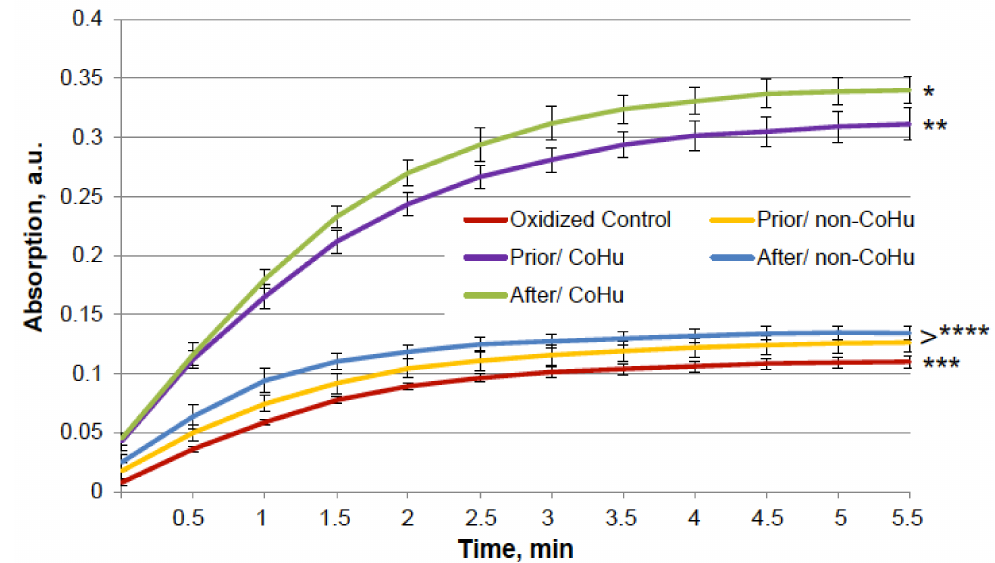
Figure 6. Effect of CoHu on oxidized alkaline phosphatase activity. Data presented as mean arbitrary units ± SD of 10 measurements. Prior/non-CoHu means that samples were treated with non-CoHu before inactivation. After/CoHu means that samples were treated with CoHu after inactivation. Prior/CoHu means that samples were treated with CoHu before inactivation. *, **, *** and ****—Lines with different superscripts differ significantly ( p < 0.05).